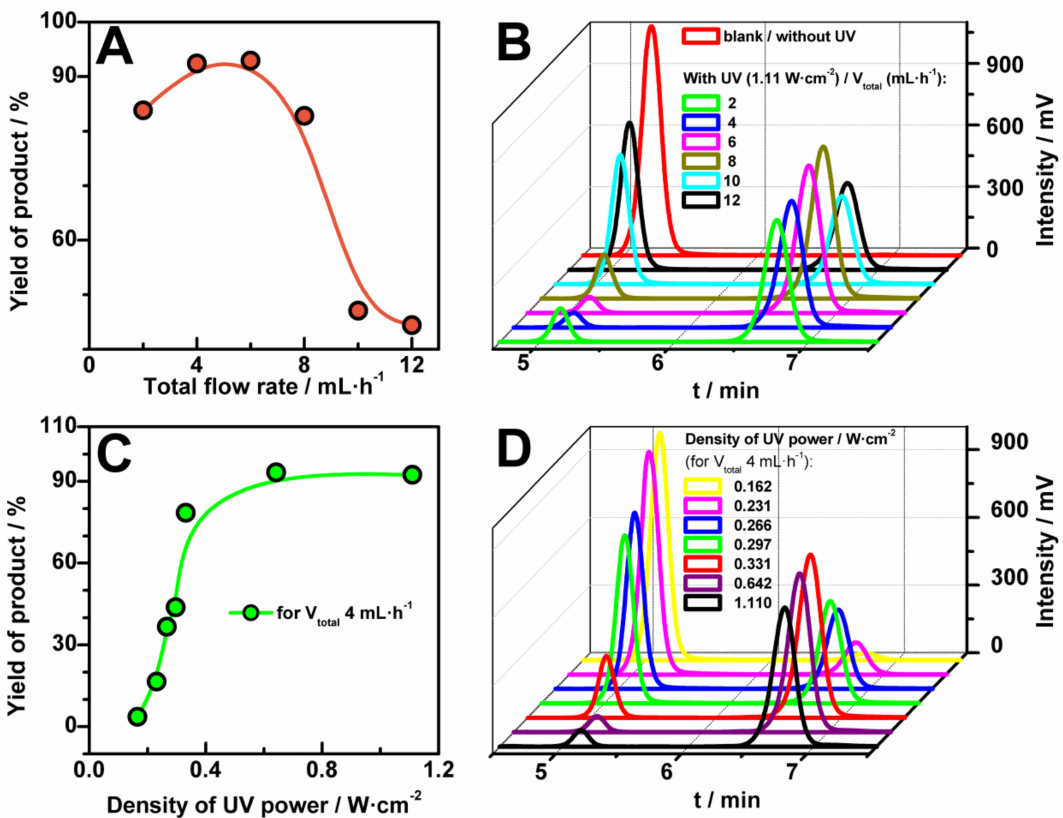
Figure 5. Yield of bromination reaction of 1-indanone ( 1 , 0.25 M) in benzylic position with the use of N-bromosuccinimide ( 2 , 0.26 M) in acetonitrile in the function of flow rate ( A ) and power of UV lamp ( C ) and the corresponding High Performance Liquid Chromatography (HPLC) chromatograms ( B , D ; eluent acetonitrile: water = 60:40). Reaction occurred at room